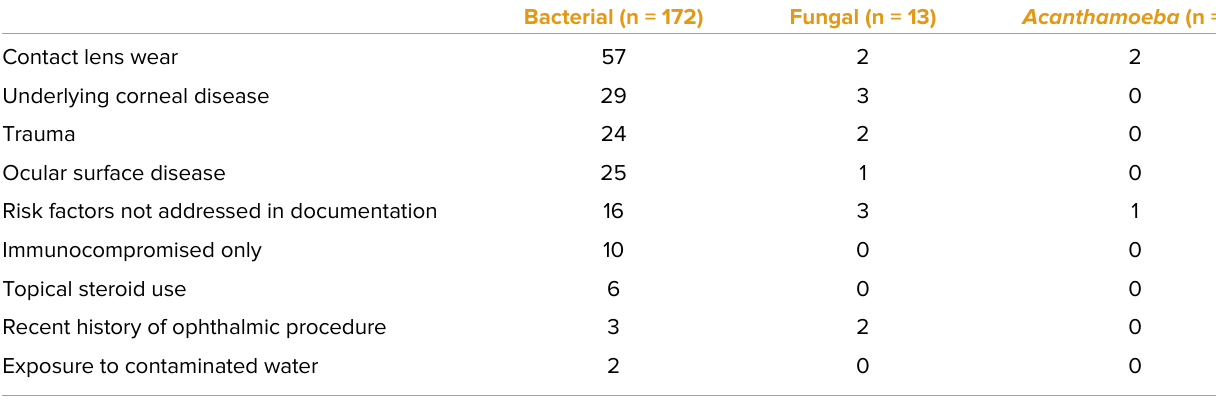
Table 2. Predisposing risk factors identified in patients with culture-proven keratitis based on etiology